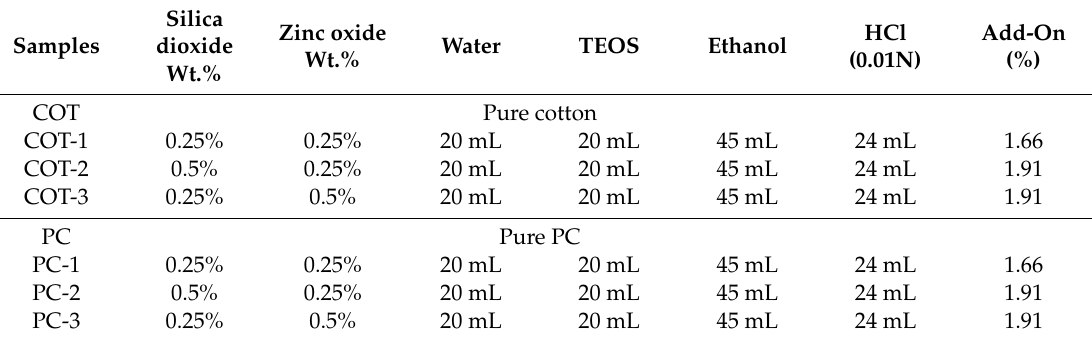
Table 2. Sol-gel